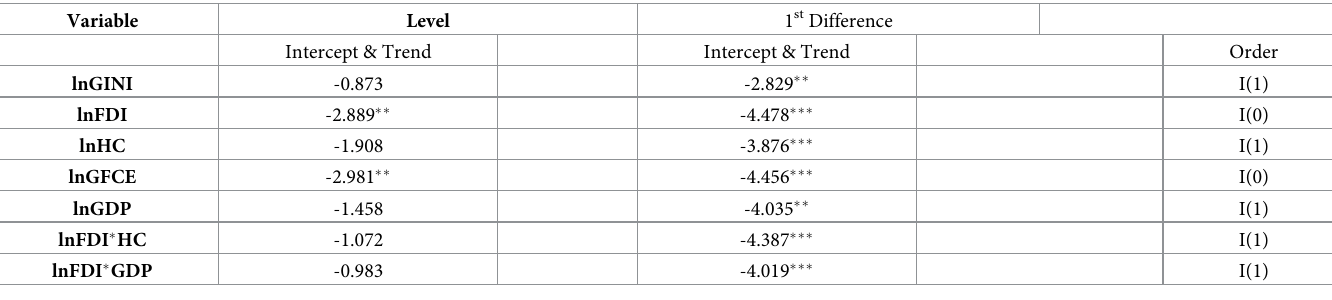
, G , P , and P t a t a,